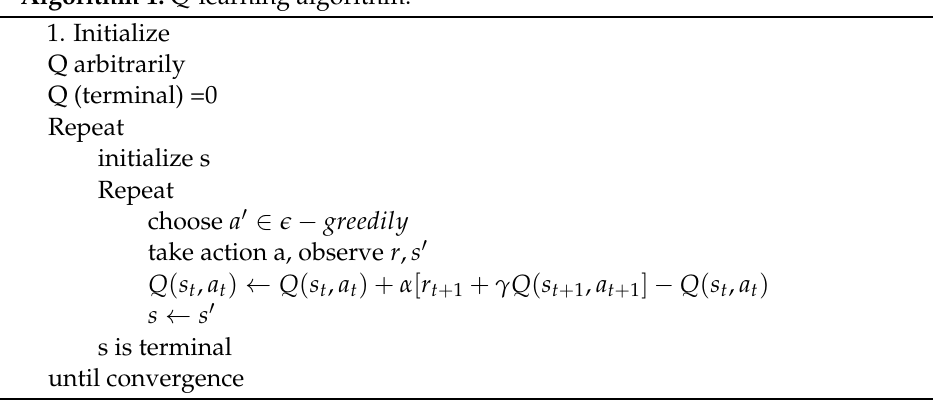
Algorithm 1: Q-learning